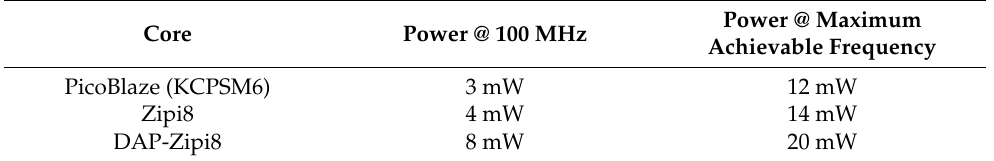
Table 4. PicoBlaze vs. Zipi8 vs. DAP-Zipi8 power utilization on a Xilinx ZCU104 development